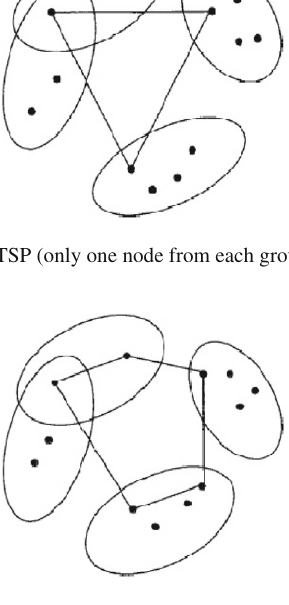
Fig. 2 Type-1 GTSP (At least one node from each